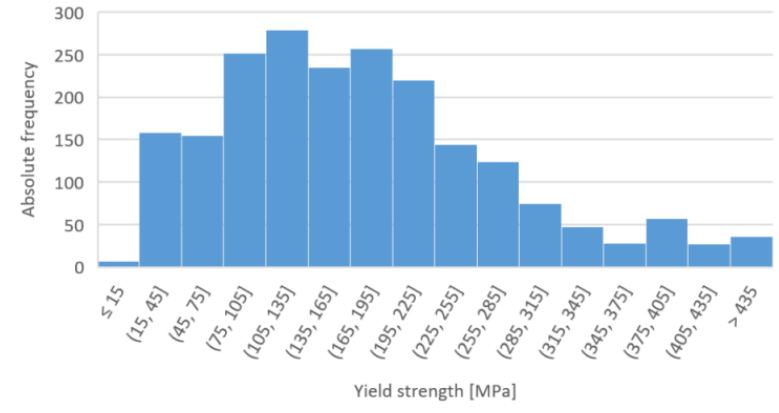
Figure 8. Yield strength histogram of the input dataset.